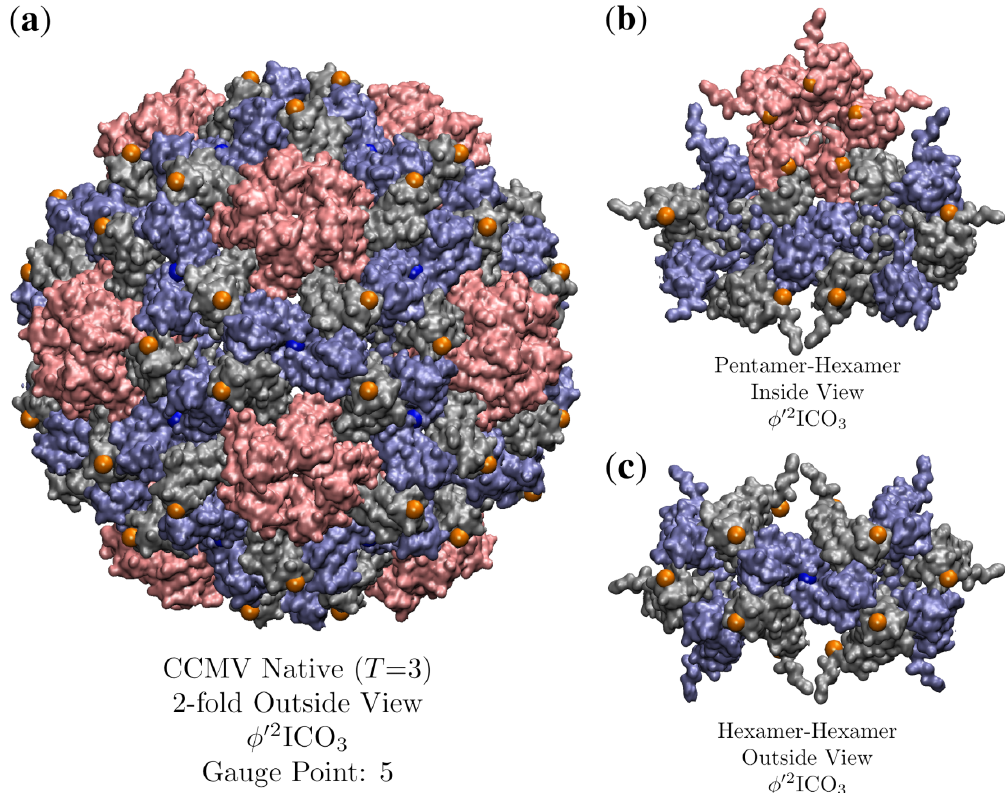
Figure 17. ( a ) A look down the 2-fold axes of CCMV ( T = 3, 1cwp [30]) which is best fitted by φ (cid:48) 2 ICO 3 with an RMSD of 0.7 Å and Gauge Point 5. The pentamers are shown in pink and the hexamers are gray and blue. ( b ) Inside the capsid view of the points as they coordinate the pentamer and hexamer meeting. ( c ) Outside view of the hexamers. The pentamer proteins only make contact with one point, though the hexmamer unit makes contact with 3 points, above, below and at their junction.